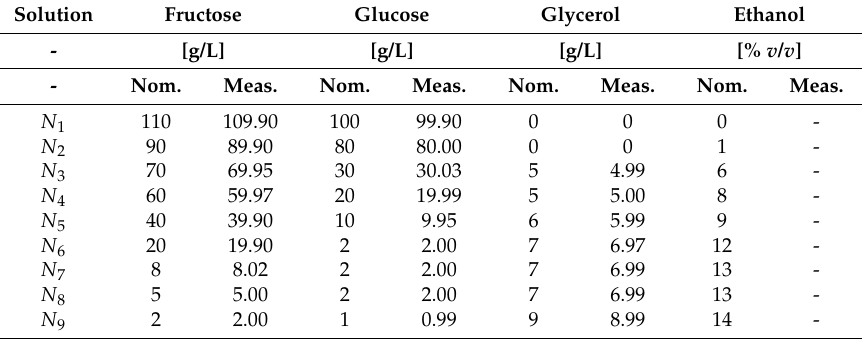
Figure 4. Representative electrical output characteristics given the conductance G and susceptance B of piezoelectric MEMS resonators when excited in the fourth-order of the roof tile-shaped mode in model solution N 1. Table 2. Composition of the model solutions representing a desired wine fermentation process from N 1 (raw grape must) up to N 9 (ordinary fermented model solution) [30]. The measured values are obtained using a R200D microscale from Sartorius.